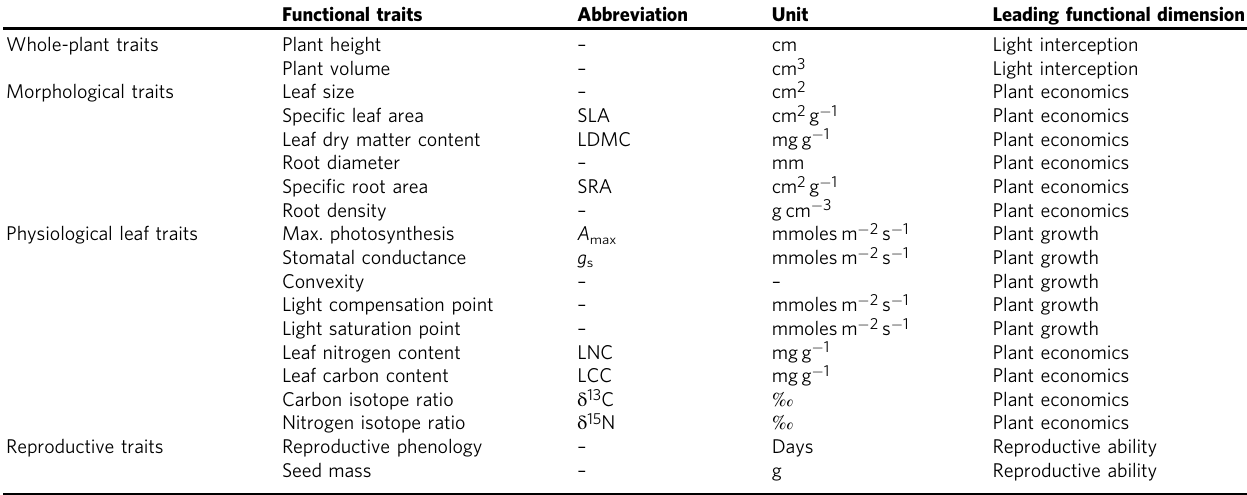
Table 1 Functional traits quanti fi ed in this study, with their abbreviations and units when relevant